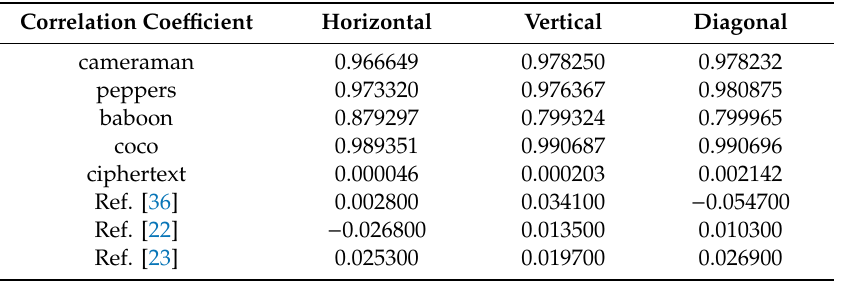
Table 2. Adjacent pixel correlation.